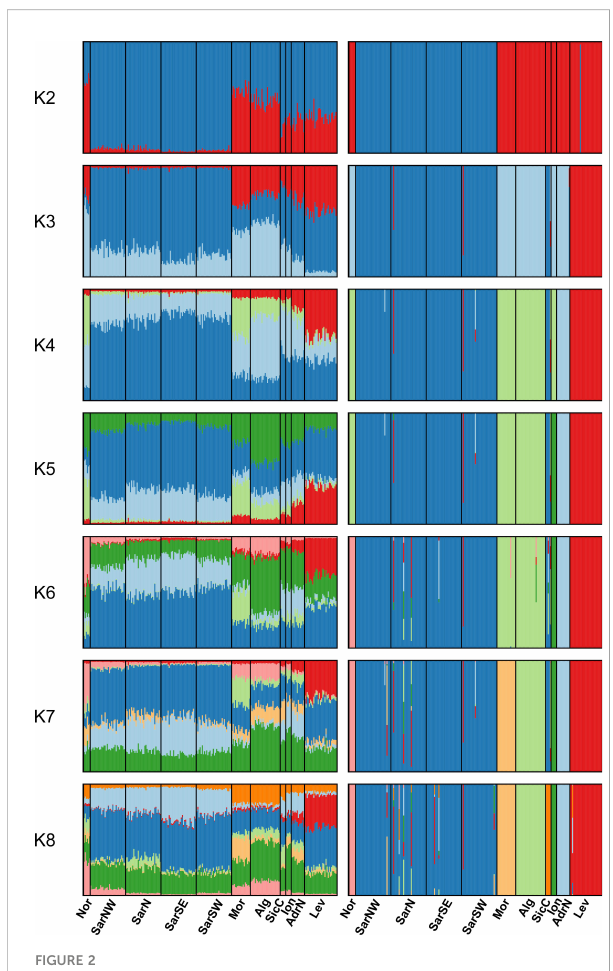
FIGURE 2 STRUCTURE (left) and BAPS (right) clustering barplots for Scyliorhinus canicula samples. Membership probabilities (q) for each individual from K = 2 to K = 8 are shown, see Table 1 for geographical location codes. Abbreviations are in accordance with Figure